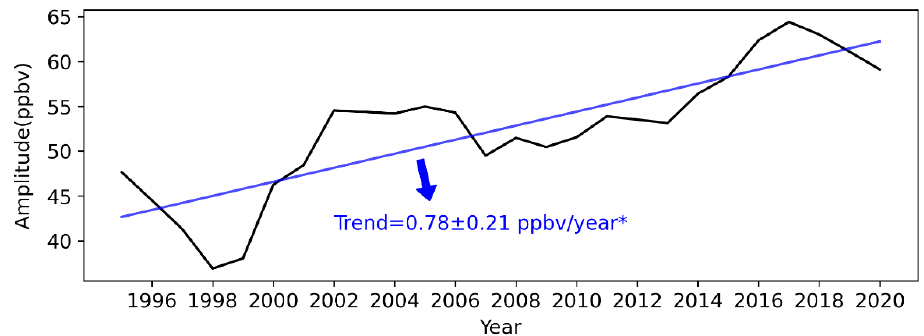
Figure 7. The amplitude of the annual cycle decomposed by STL and its trend from 1995 to 2020. The “*” stands for that trend can pass the 95% significance test.